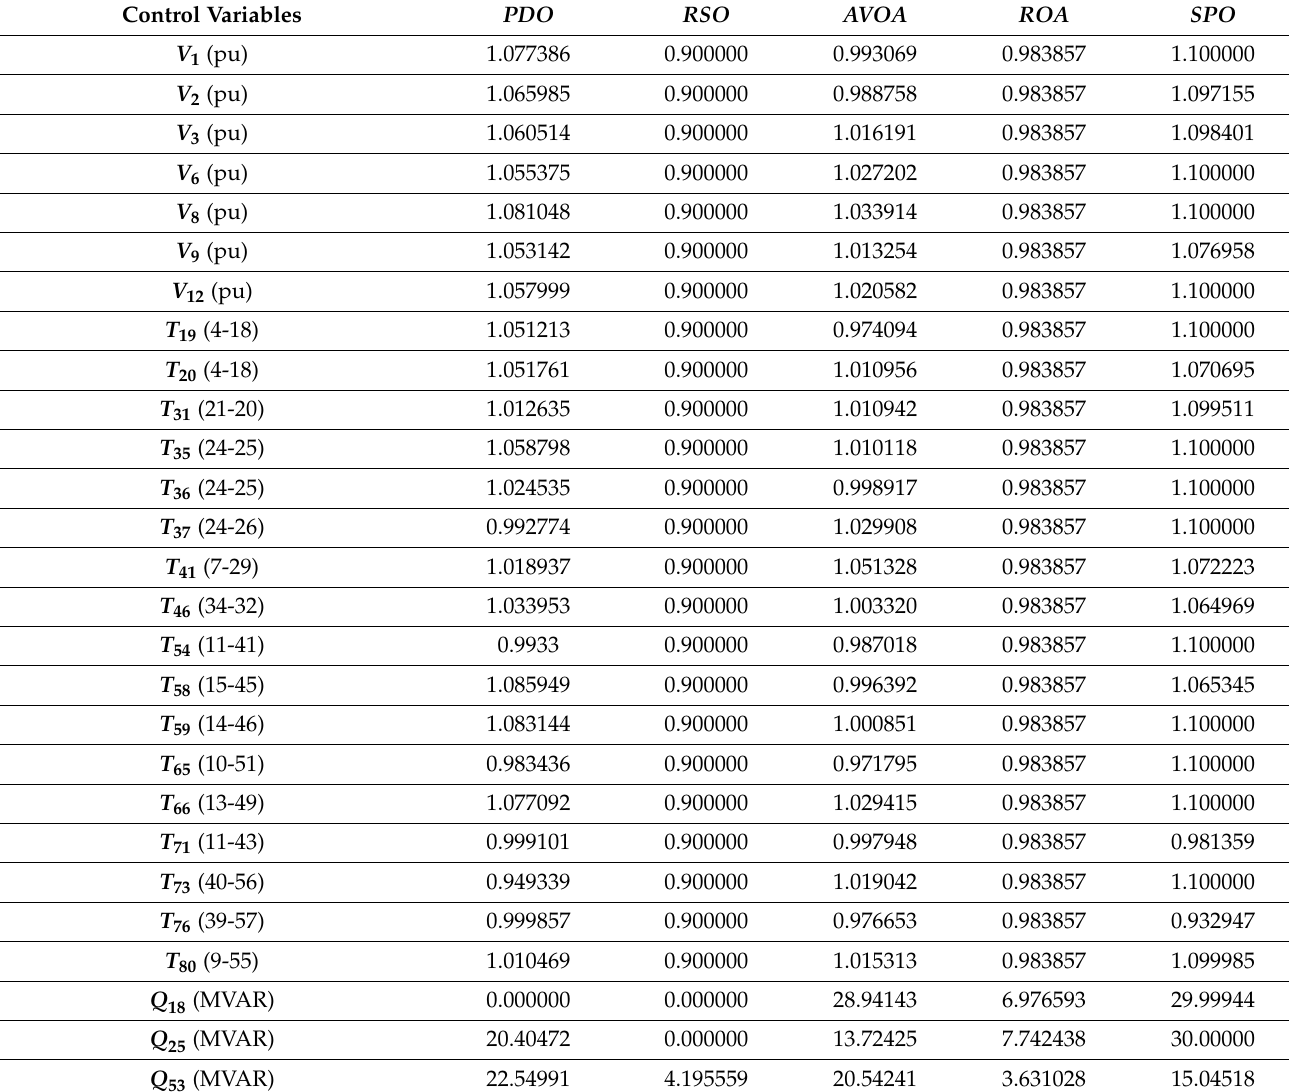
Table 22. Optimal IEEE 57-bus test system control variables for reducing power losses with incorpo- ration of